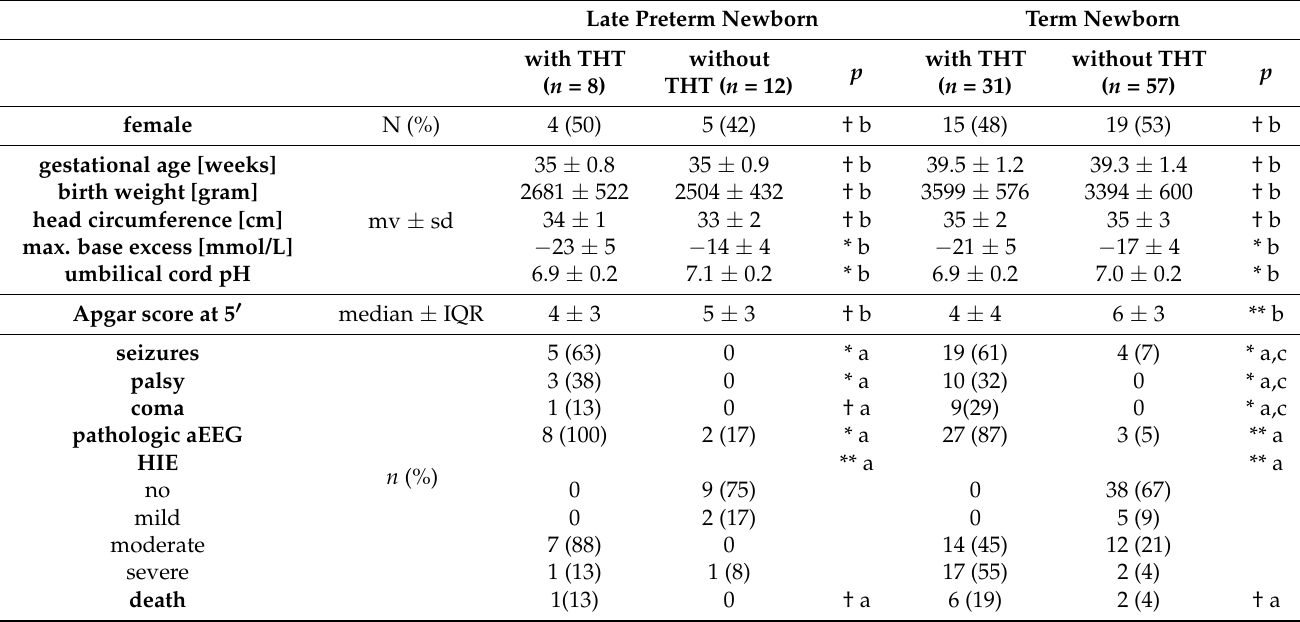
Table 1. Baseline characteristics of newborns with and without therapeutic hypothermia at discharge.